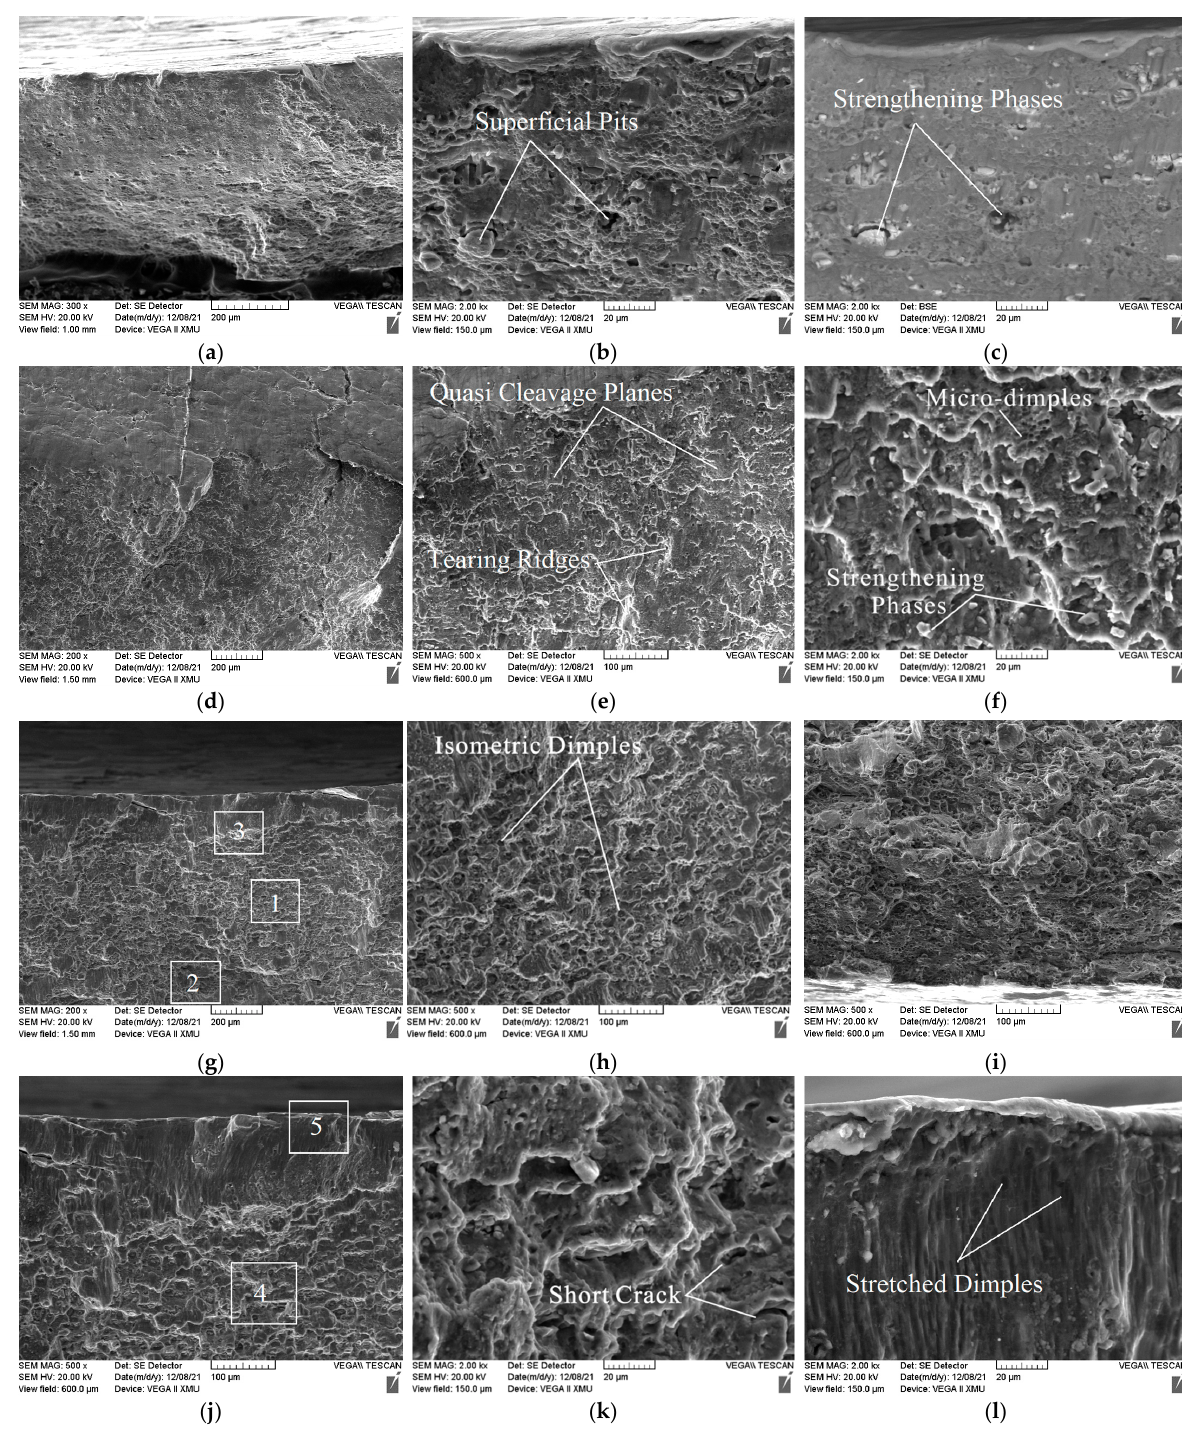
Figure 7. The fracture morphology of the processed specimens for SPIF, LUVIF, and 2D-UVIF (SEM images of SE (secondary electrons) and BSE (backscatter electrons)). ( a ) SPIF, SE, 200×; ( b ) SPIF, SE, 2KX; ( c ) SPIF, BSE, 2KX; ( d ) LUVIF, SE, 200X; ( e ) LUVIF, SE, 500×; ( f ) LUVIF, SE, 2KX; ( g ) 2D-UVIF, SE, 200×; ( h ) 2D-UVIF, SE, 500X, District 1; ( i ) 2D-UVIF, SE, 500×, District 2; ( j ) 2D-UVIF, SE, 500×, District 3; ( k ) 2D-UVIF, SE, 2KX, District 4; ( l ) 2D-UVIF, SE, 2KX, District 5; 2D-EUVIF is the abbreviation for 2D ellipse ultrasonic vibration incremental forming; LUVIF is the abbreviation for longitudinal ultrasonic vibration incremental forming; SPIF is the abbreviation for single-point incremental forming. Notes: The numbers 1–5 with white boxes in ( g , j ) represent five testing areas and their magnified im-ages are accordingly showed in ( h – l